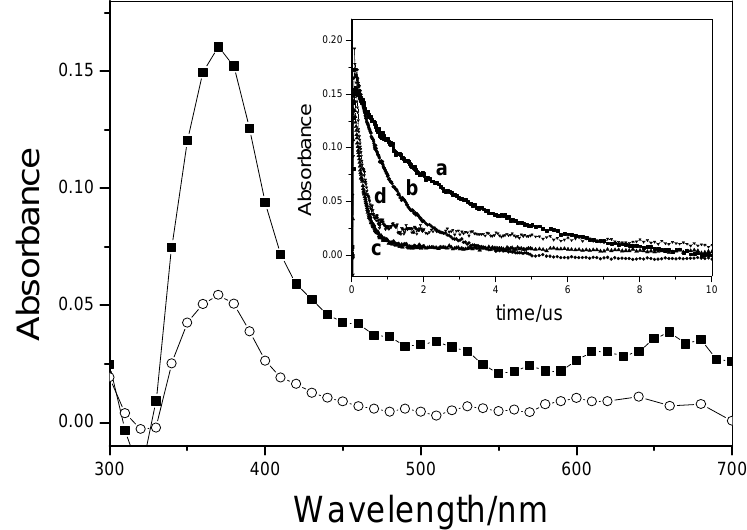
Figure 1. Transient absorption spectra of AQ recorded at 1 µ s after 355 nm laser excitation in RTIL /MeCN solution ( V =0.2 ， corresponding to mole fraction of 0.06) containing 1 · 10 -4 mol (cid:215) dm -3 RTIL